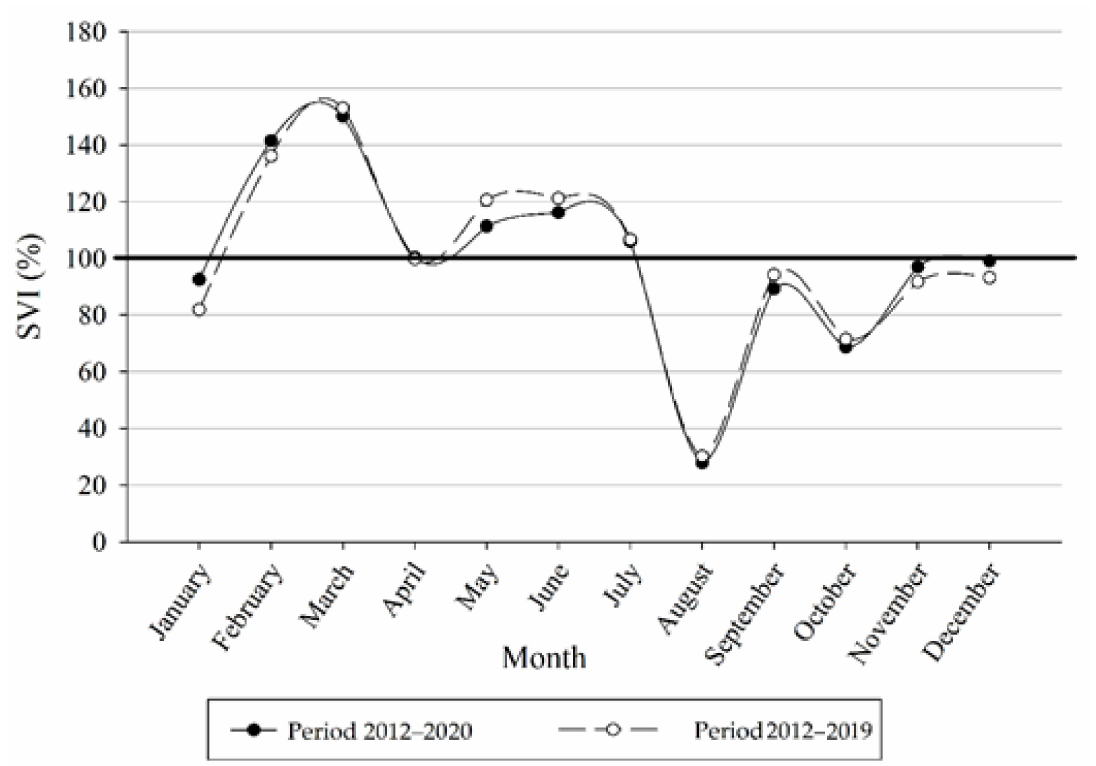
Figure 18. Seasonality pattern of vehicle embarking traffic of the port of Tarragona during the periods 2012–2019 and 2012–2020.